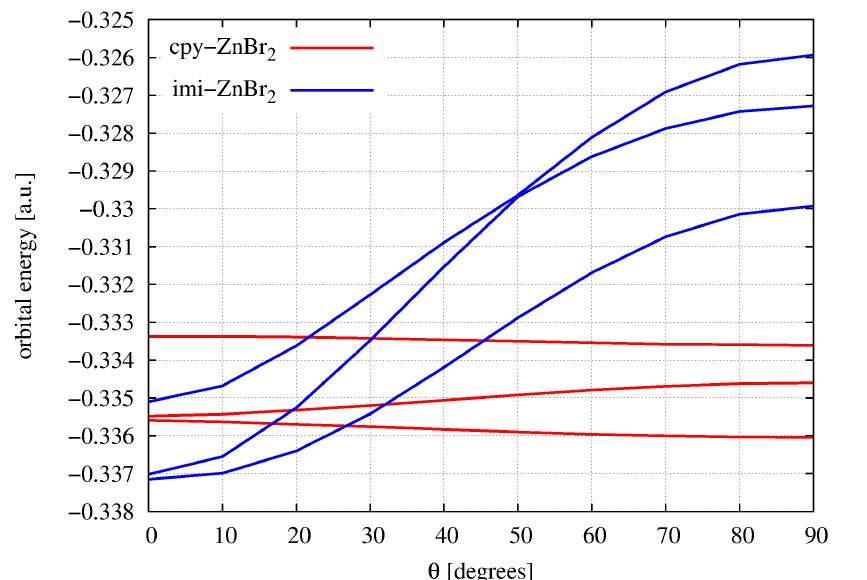
Figure 4. Dependence of the orbital energy of the three highest occupied orbitals (i.e., HOMO, HOMO-1 and HOMO-2) on the twist angle of the ZnBr 2 unit plane with respect to the carbene plane for dimers cyclopropenylidene · · · ZnBr 2 (cpy-ZnBr 2 ) and imidazol-2-ylidene · · · ZnBr 2 (imi-ZnBr 2